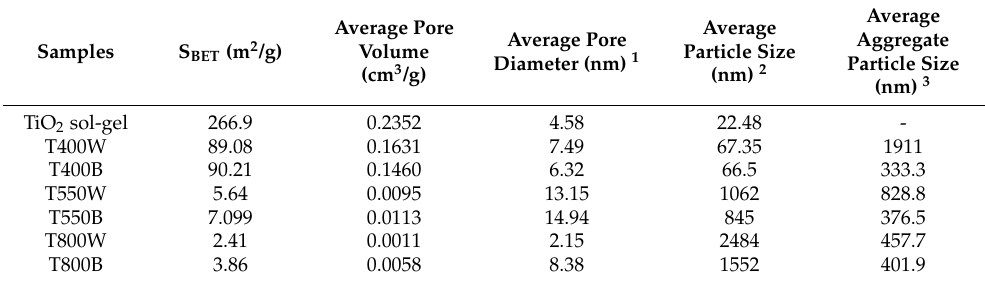
Table 1. Specific surface area (S BET ), average pore volume and pore diameter, and average particle size for TiO 2